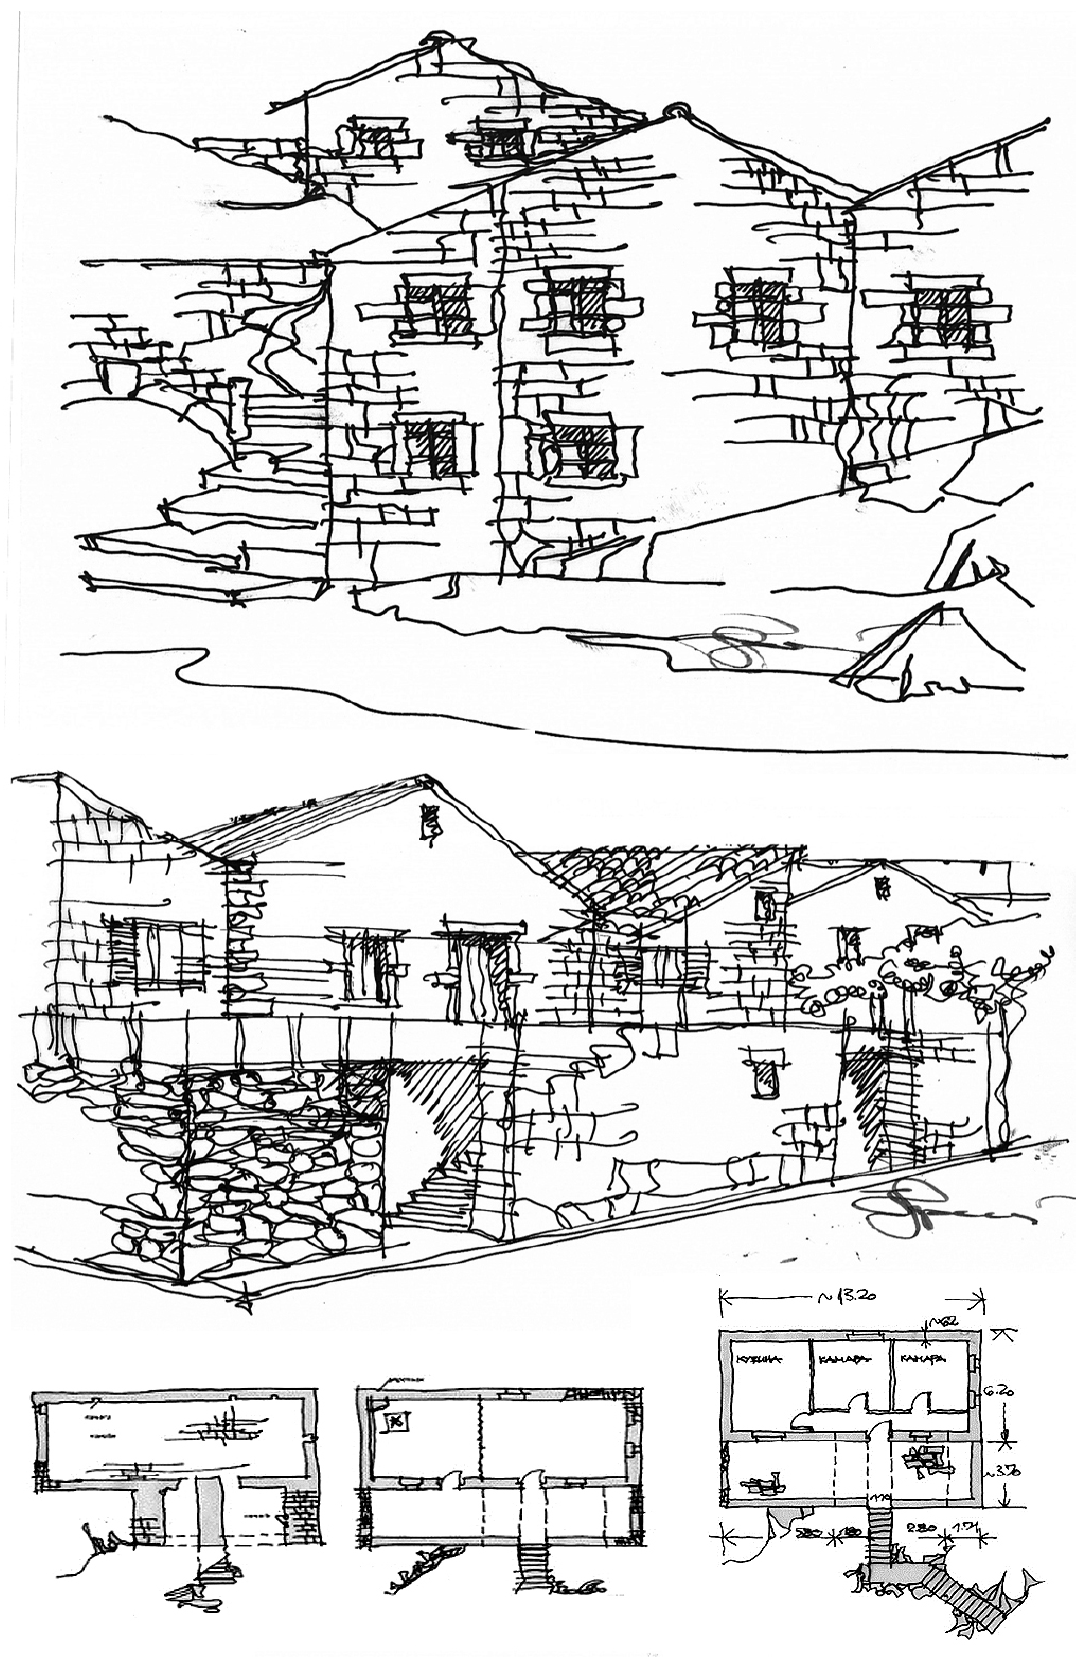
Figure 21. Drawing of Vranjina settlement, Zeta region, Montenegro (S. G. Popovic).